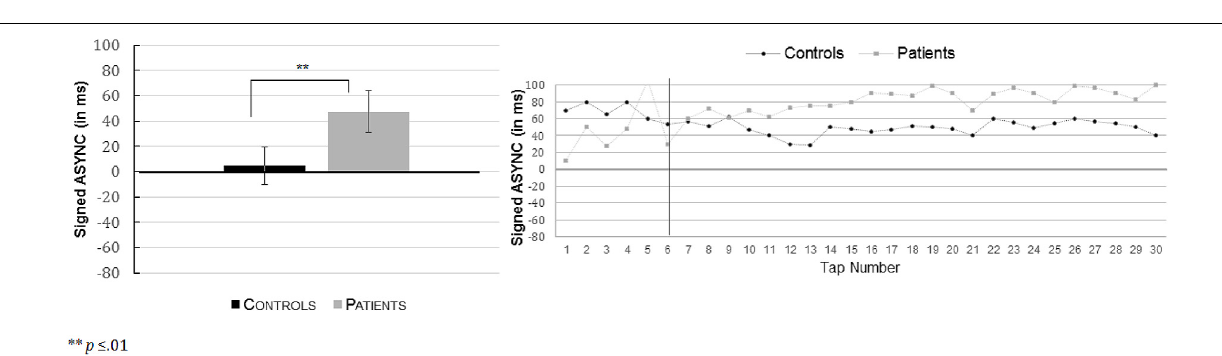
= 0.001. The findings indicated a similar p = 0.872, η 2 p